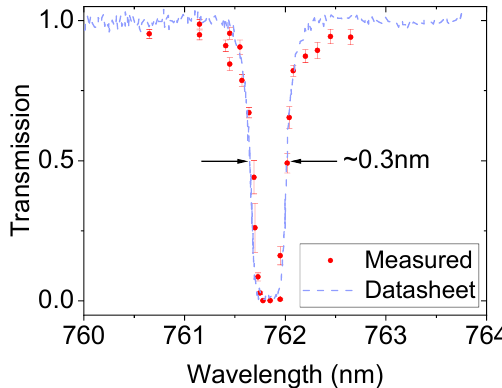
Figure 2. Measured VBG transmission spectrum.